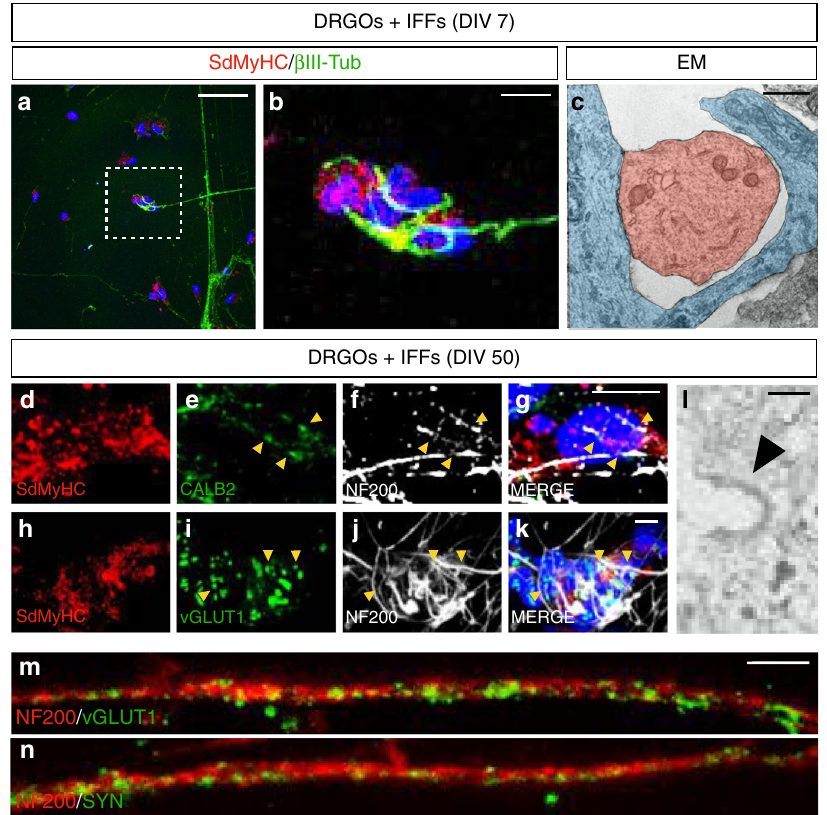
Fig. 4 In vitro reconstitution of the muscle spindles. a Co-cultures of DRGOs and intrafusal muscle fi bers (IFFs) at DIV 7 with single axonal projections contacting IFFs visualized by immuno fl uorescence staining for the intrafusal muscle fi ber marker S46 (red), and the neuronal protein ßIII-Tubulin (green). Scale bar, 50 µ m. b Enlarged view of the boxed area in a reveals the annulospiral wrapping of the axonal terminal around the multinucleated intrafusal muscle fi ber within the central domain where nuclei are concentrated (blue, nuclear staining with Hoechst). Scale bar, 10 µ m. c Electron microscopy (EM) imaging showing an axonal process (blue) which is wrapping a segment of the intrafusal muscle fi ber (red). Scale bar, 1 μ m. d – k Calretinin (CALB2) ( d – g ) and vGLUT1 ( h – k ) staining (arrowheads) along the NF200 + annulospiral axonal terminals of DRGOs in co-cultures with intrafusal muscle fi bers (IFFs) stained with S46 at DIV 50. Scale bar, 10 μ m. l Electron microscopy imaging showing an invaginating clathrin-coated vesicle (arrowhead) within the axonal terminal. Scale bar, 100 nm. m , n Immuno fl uorescence for the synaptic vesicle markers Synapsin and vGLUT1 (green) within axonal fascicles labeled by NF200 (red). Scale bar, 5 μ